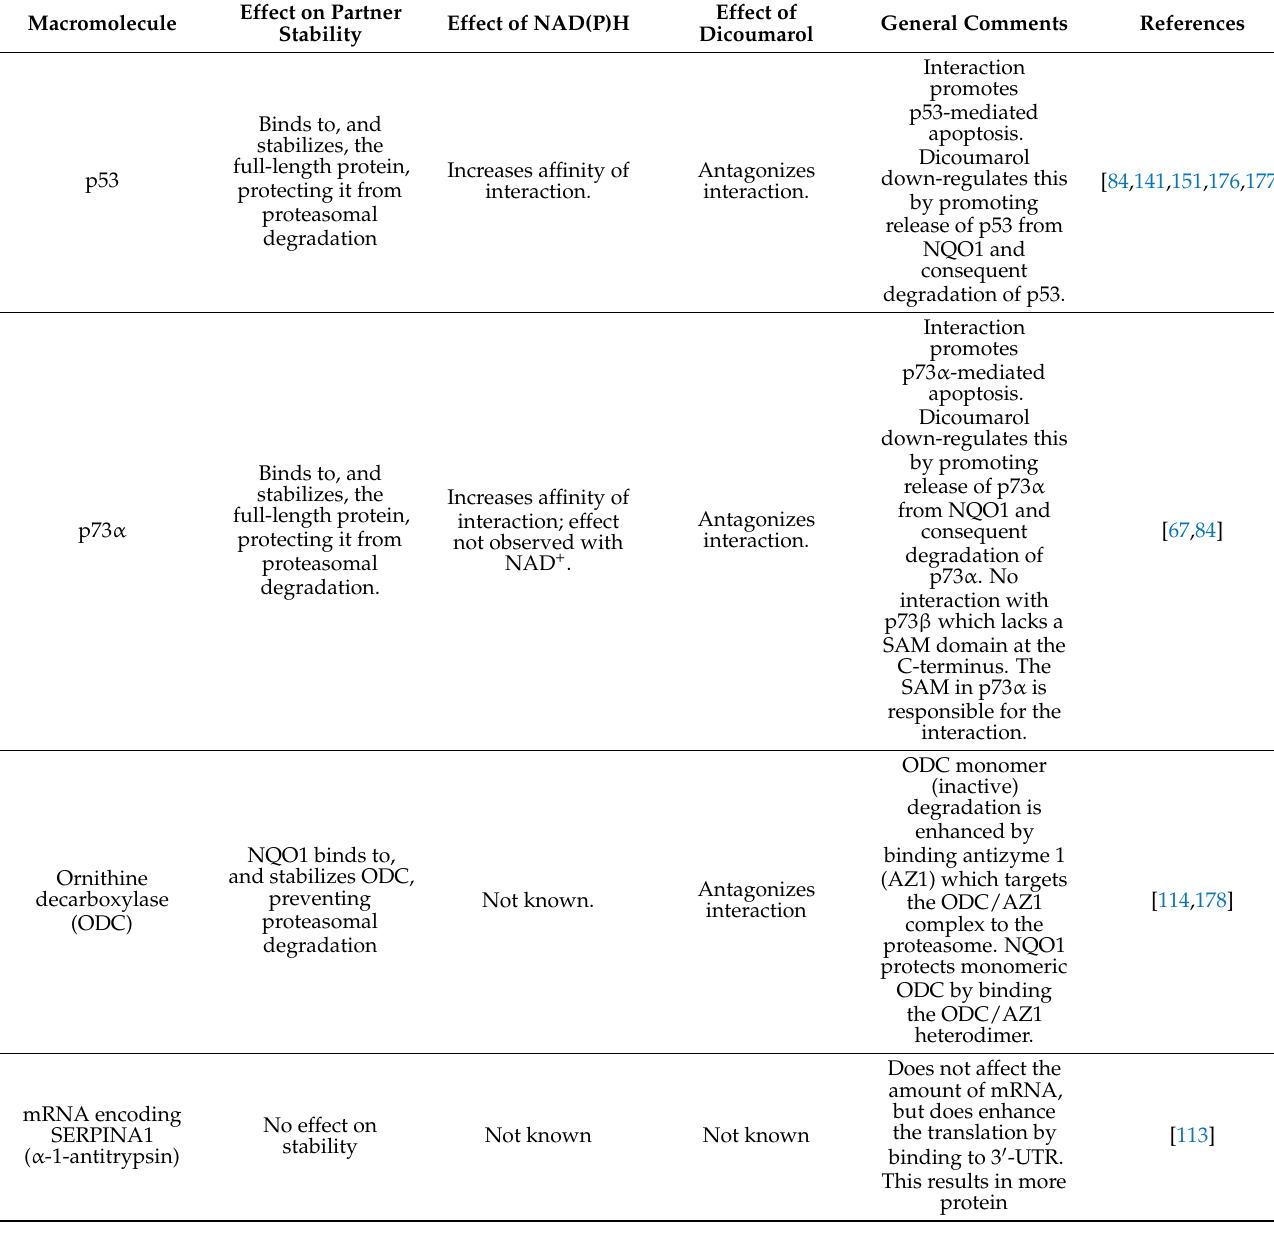
Table A2. Macromolecular binding partners of NQO1 and effects of ligand